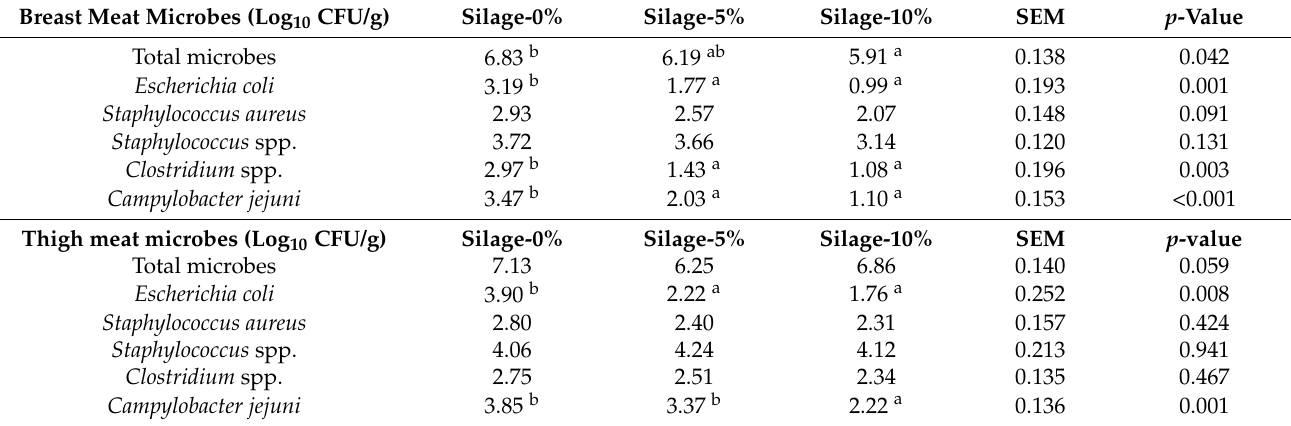
Table 7. Effect of silage supplementation on broiler breast and thigh meat microbial populations.